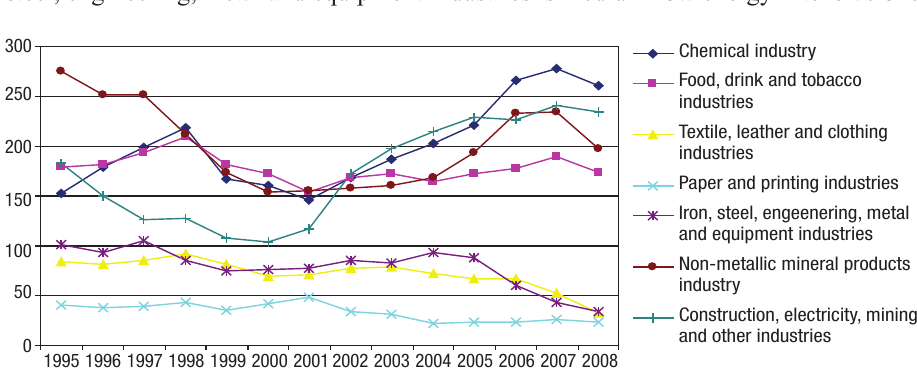
Fig. 9. Final Lithuania‘s energy consumption by main industrial sectors during 1995–2008, ktoe Source : Table 4. Final Lithuania‘s energy consumption taxonomy by main industrial sectors, average 2005–2008 (%) Energy/VA Groups of energy (%)